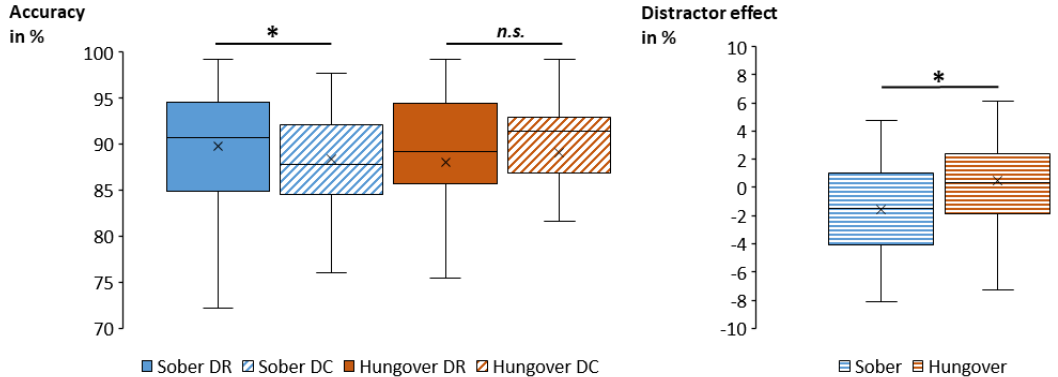
Figure 5. Box plots of the obtained mean probe accuracy (in percent) for the significant interaction of status and distractor are illustrated in the left graph. While the accuracy was significantly higher in DR trials (89.8 % ± 1.1) than in DC trials (88.4 % ± 1.1) when being sober, there was no such significant di ff erence when being hungover. Consequently, the size of the distractor e ff ect (the di ff erence between DC and DR) was significantly smaller in the hangover assessment than in the sober assessment (right graph). Abbreviations: DR = distractor repetition; DC = distractor change; * = p < 0.05; n.s. = non-significant.